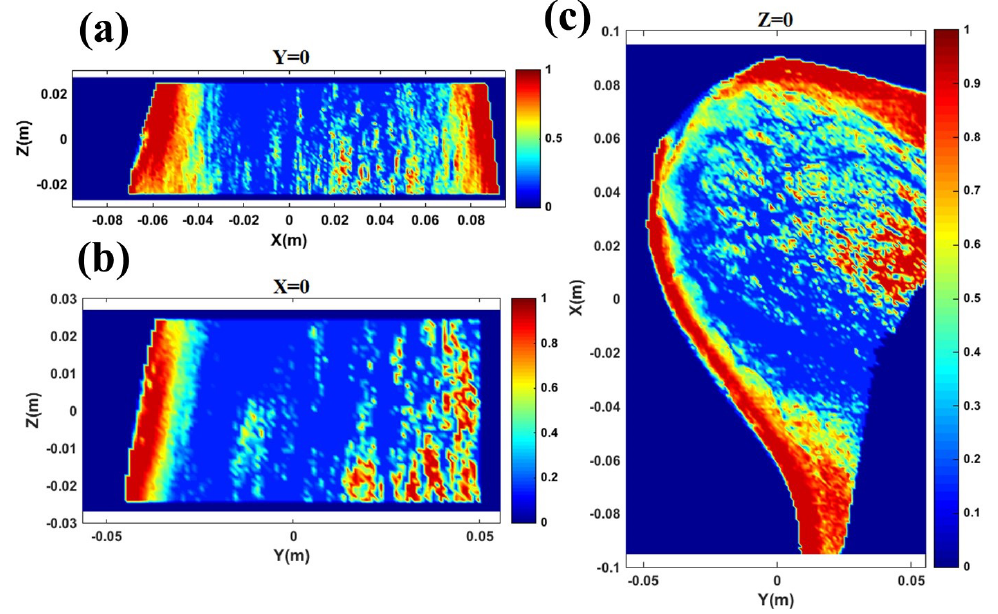
Figure 11. Fat distribution (dark red corresponds to 100% fat) in a healthy breast from a DBT image as seen from ( a ) front, ( b ) side, ( c ) and above. The margins of the breast are composed of 80–100%